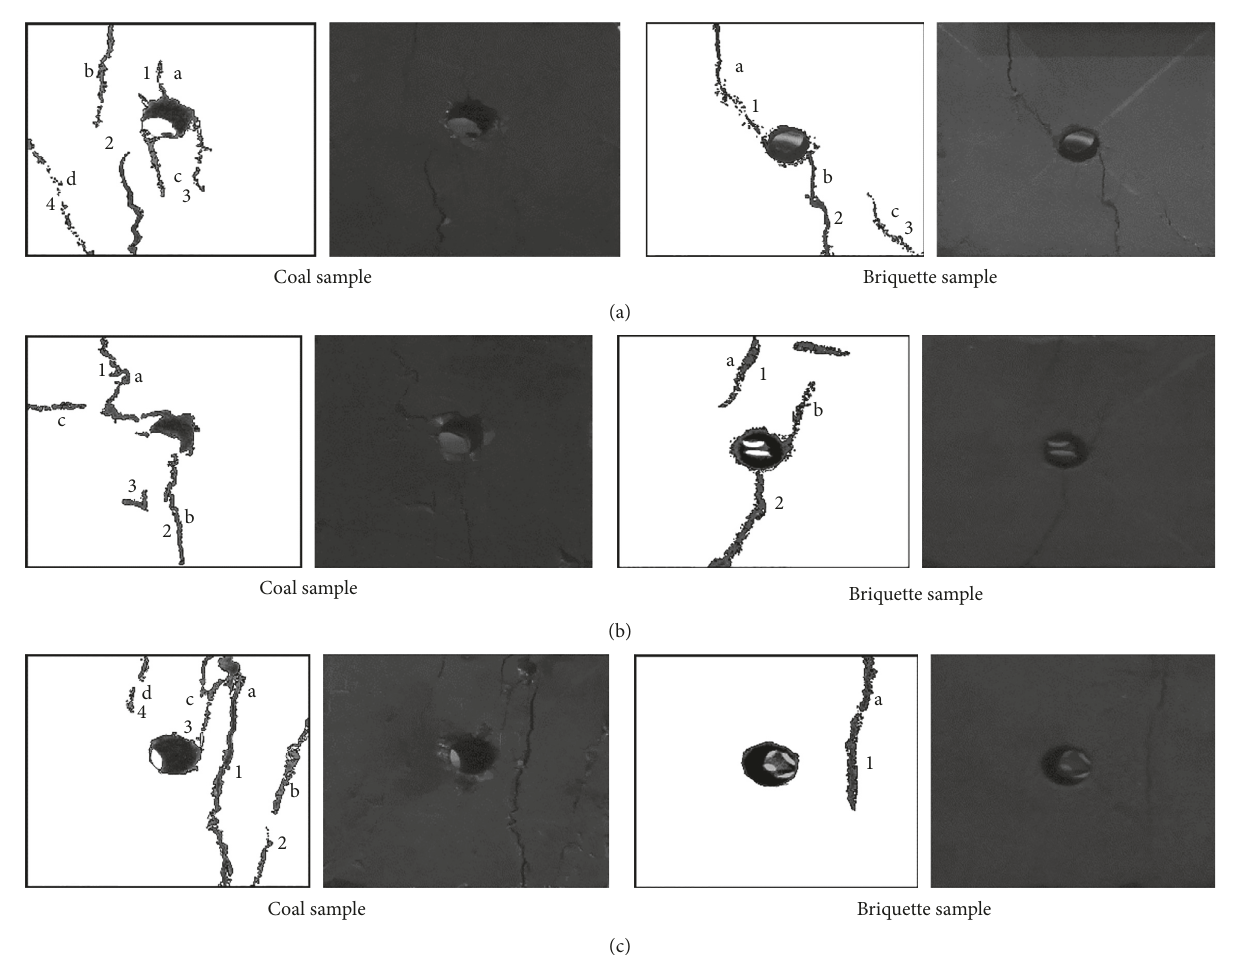
Figure 10: Initiation position of cracks generated in the two types of samples. (a) Action area 3S/4; (b) action area 2S/4; (c) action area